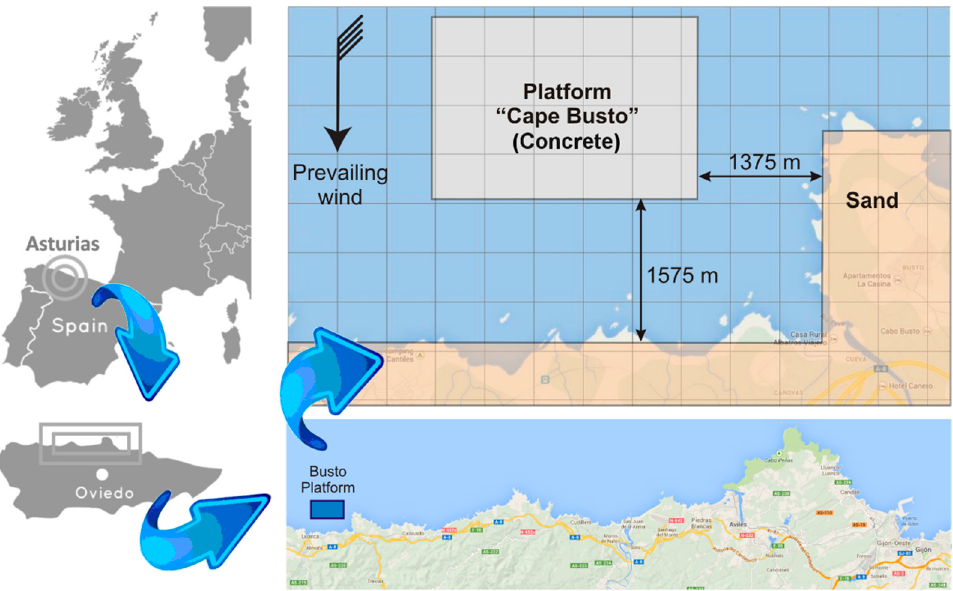
Figure 1. Location of the Cape Busto platform and simulated geometry.